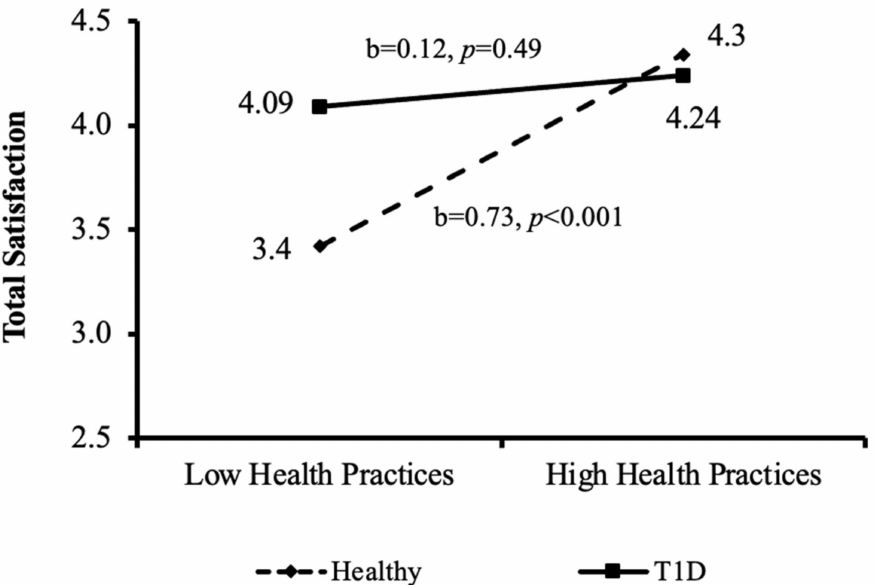
Figure 3. Interactions between the independent variable (good health practices) and the mediat- ing variable (total satisfaction) by the moderating variable (health condition group); T1D= type–1